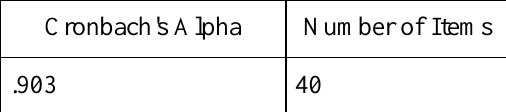
Table 01: Reliability Statistics